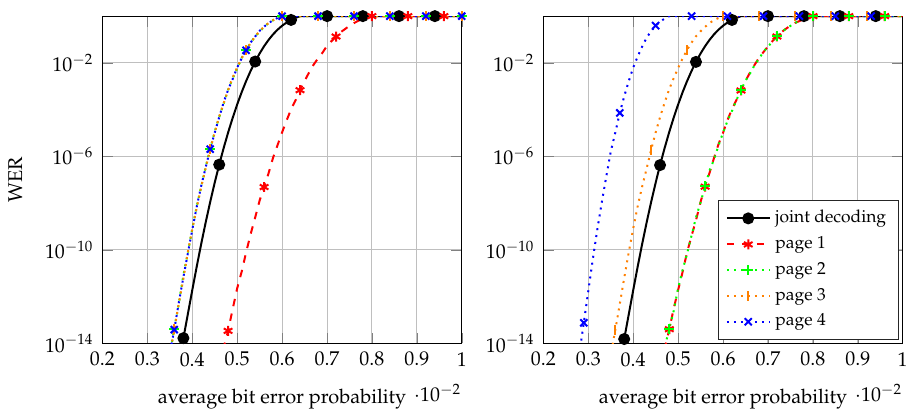
Figure 8. GC codes (from Table 5) of rate R = 0.9 and 4 kB of payload data for a QLC model using Gray code 4 ( left ) and Gray code 5 ( right ).